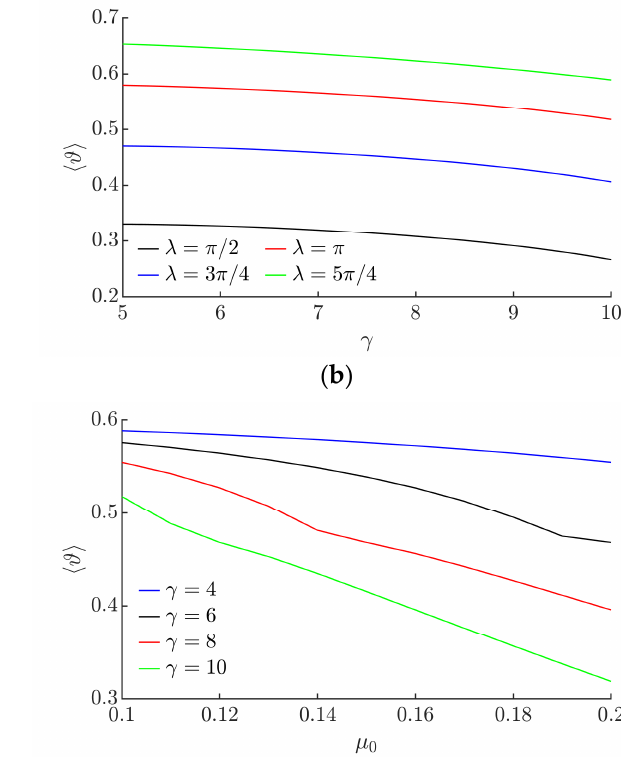
9 of 19 Figure 6. Variation of the angular velocity vector during the period of the eighth cycle of circular motion in polar coordinates when ⟨ μ m ⟩ / μ 0 = 0.25, γ = 4.9: ( a ) μ 0 = 0.1; ( b ) μ 0 = 0.2. The variation of the angular velocity vector during a stable period of the circular mo- tion is shown in Figure 7a. The magnitude of the angular velocity vector  oscillates over some positive value under the influence of dynamic dry friction control. The amplitude of these oscillations depends on λ . These oscillations indicate that the particle is gaining displacement. An increase in λ results in a higher value of this amplitude. Figure 7b shows how the phase of the vector of angular velocity varies over nondimensional time. ( a ) ( b ) Figure 7. Angular velocity vector vs. the nondimensional time when μ 0 = 0.2, ⟨ μ m ⟩ / μ 0 = 0.25, γ = 4.9: ( a ) magnitude  during the period of the 8th cycle; ( b ) phase θ during the first four cycles.